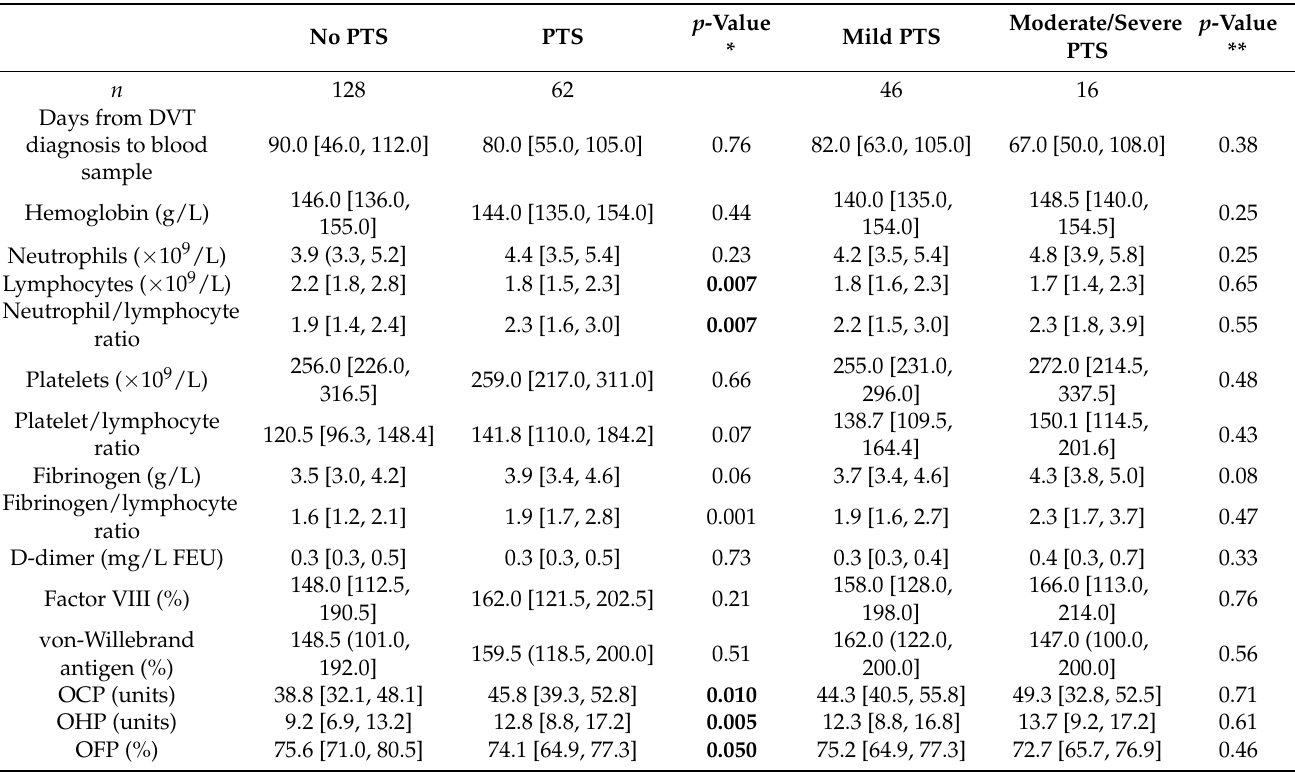
Table 3. Results of biomarkers according to post-thrombotic syndrome. Data are in n (%), and median [interquartile range,